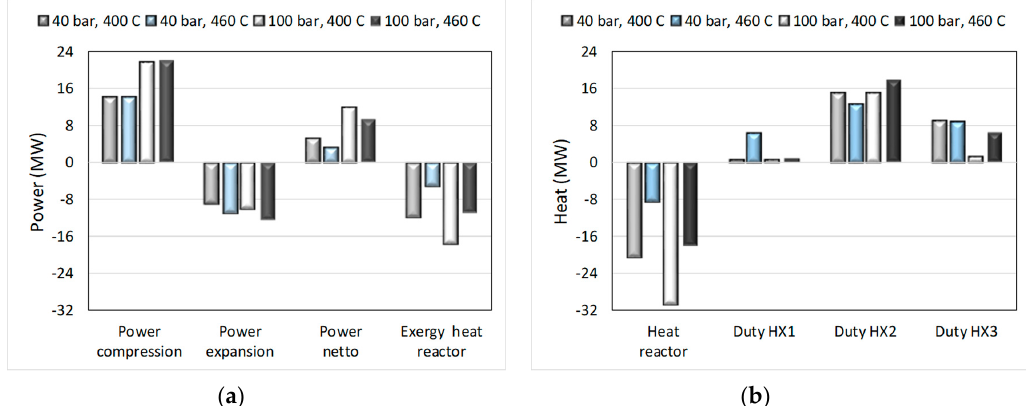
Figure 14. Energy input and output and heat exchanger duties for process conditions as indicated for the process shown in Figure 13. Power in/out and exergy of reaction heat ( a ) and heat of reaction and heat duties of heat exchangers ( b ). 3.3. Metallic NP Production Using an Arc Discharge Route